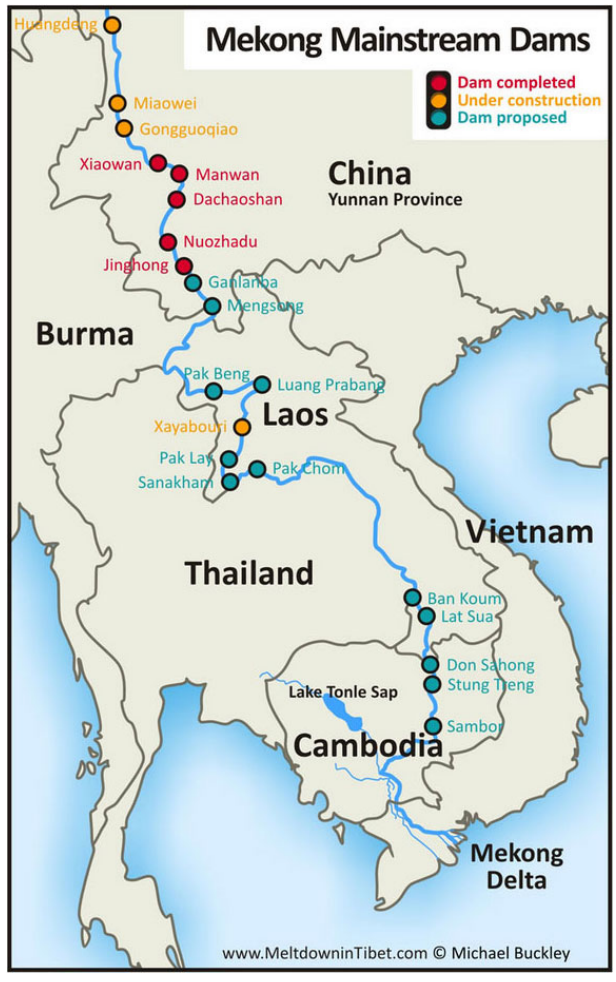
Fig. 1. Map showing the locations of mainstream dams in the Mekong basin as of 2014. Source: http://www. MeltdowninTibet.com, © Michael Buckley.